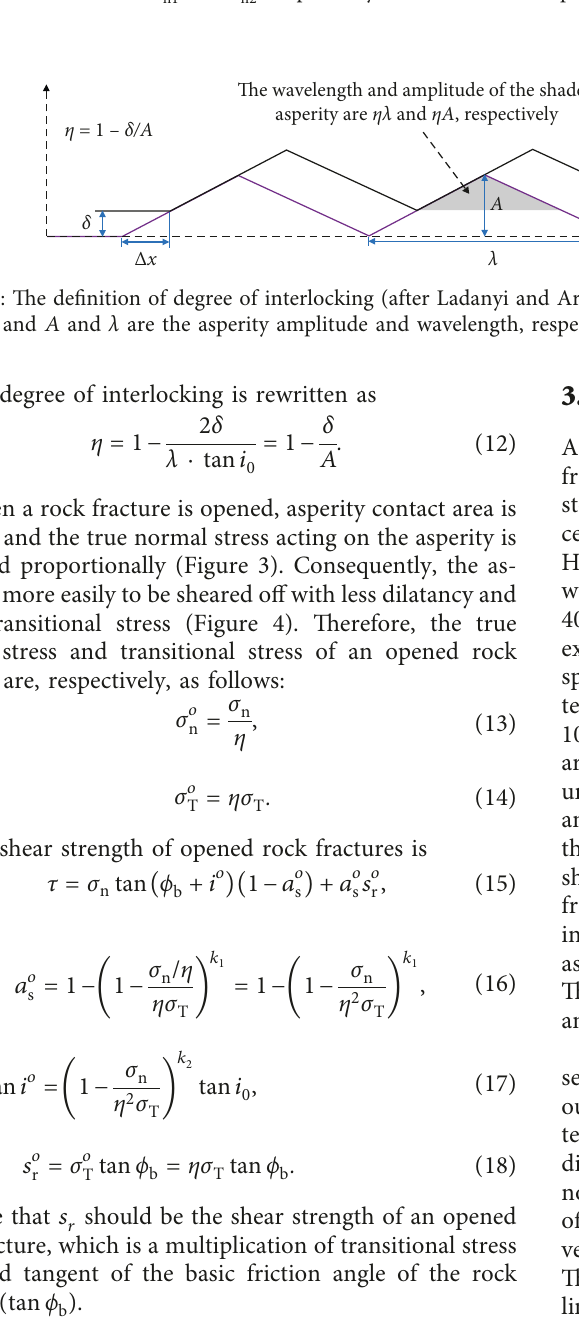
Figure 2: Dilation angles and shear-off areas of fracture asperities under low and high normal stresses, respectively. τ and σ stress and shear stress, respectively. S and S normal stress under which the peak dilation angle is i the difference of shear-off area under normal stresses σ under normal stresses of σ